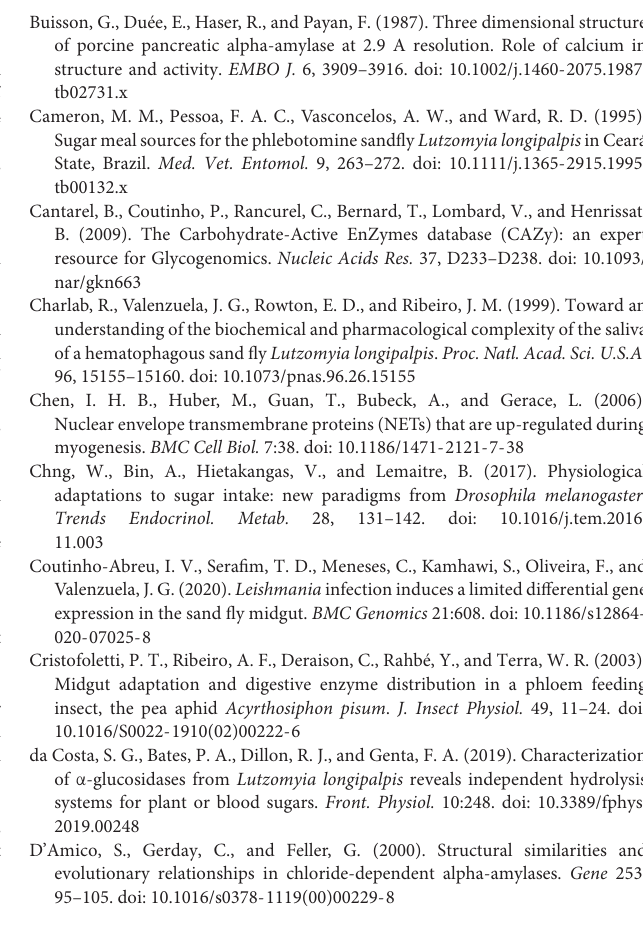
Supplementary Figure 1 | Schematic diagram of exon and intron composition of L. longipalpis genes belonging to GH13 and GH31. Sequences were retrieved from Vector Base (Jacobina strain, LlonJ1.4 geneset, June 2017). Green boxes and lines represent exons and introns, dotted lines and boxes represent missing parts in incomplete sequences. For incomplete sequences, structures were designed based on homology with orthologous sequences. Supplementary Table 1 | Identifiers and accession numbers of insect GH13 protein sequences used for the phylogenetic tree of Figure 2 . Supplementary Table 2 | Identifiers and accession numbers of insect GH31 protein sequences used for the phylogenetic tree of Figure 3 . Supplementary Table 3 | List and sequences of the RT-qPCR primers used for PCR-amplification of cDNA sequences codifying for proteins belonging to GH13 and GH31 of L. longipalpis .